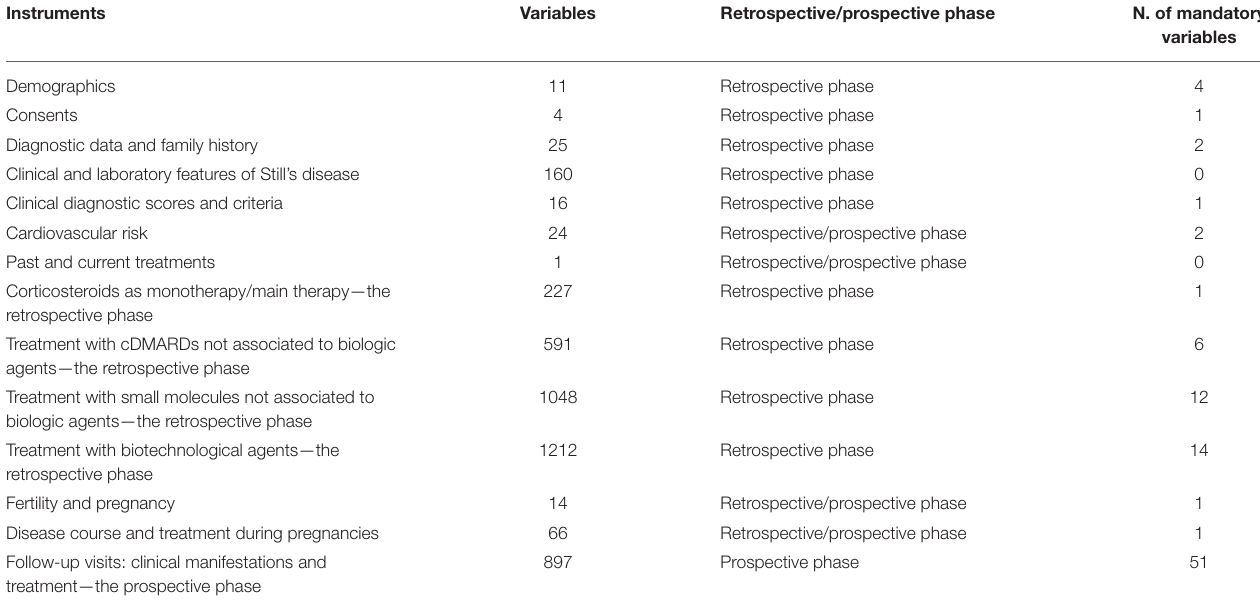
TABLE 2 | List of instruments included in the Registry dedicated to patients with Still’s disease, with the corresponding number of common data elements, the phase (i.e., retrospective/prospective) at which they should refer to and the number of mandatory variables included.